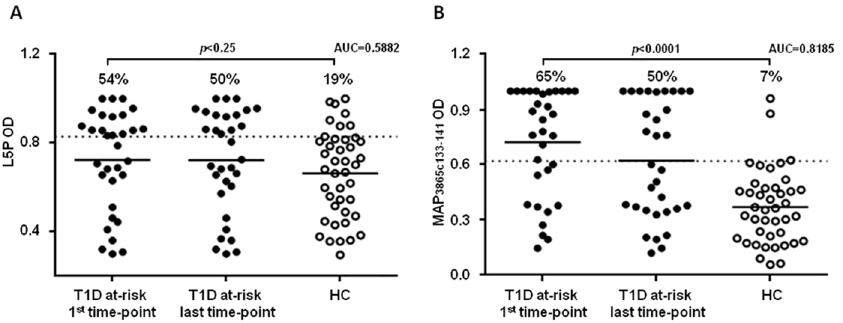
Fig 1. Prevalence of Abs against L5P and MAP-derived ZnT8 homolog in T1D at-risk subjects and HC. Plasma samples were analyzed in duplicate for Abs directed against L5P (A) and MAP3865c 133-141 (B) epitopes. Distributions are relative to the sample sets including only the first or the last time-point collection in comparison to HC. Horizontal bars indicate means. The dotted line corresponds to the Abs positivity threshold. AUC and p -values relative to T1D at-risk subjects vs. HC test are given in the upper part. Specific percentage of reactivity is indicated above each